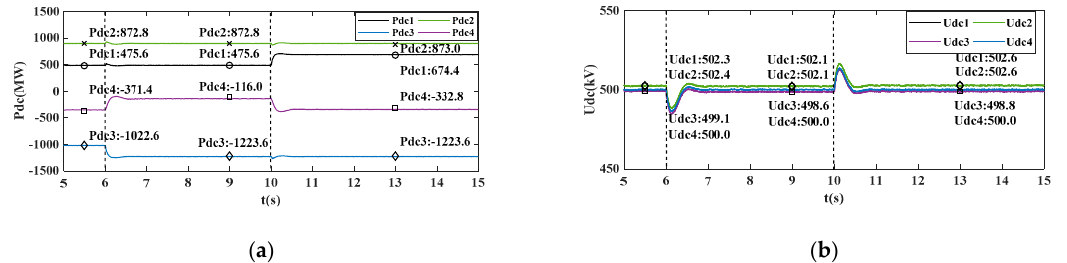
Figure 8. The simulation results in PSCAD. ( a ) Curves of the DC active power with the master-slave control; ( b ) Curves of the DC voltage with the master-slave control.